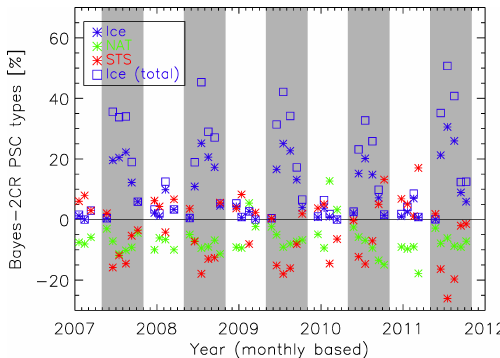
Figure 11. Differences in partitioning of the three PSC types be- tween the new Bayesian classifier and the 2CR method based on all classified MIPAS spectra for each month of the years. SH analyses are highlighted by the grey shaded areas; NH data are in the white areas. In addition, the probability of the Bayes ice class with respect to all analysed PSC spectra is superimposed (blue open squares). This number visualizes the relevance of ice clouds at the specific time of the PSC season. For the comparison, we added the Bayes STS_NAT class to the STS class, which is in line with the definition of three classes attributed by the 2CR method (for details see